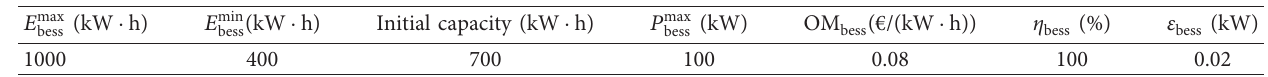
Table 5: Parameters of